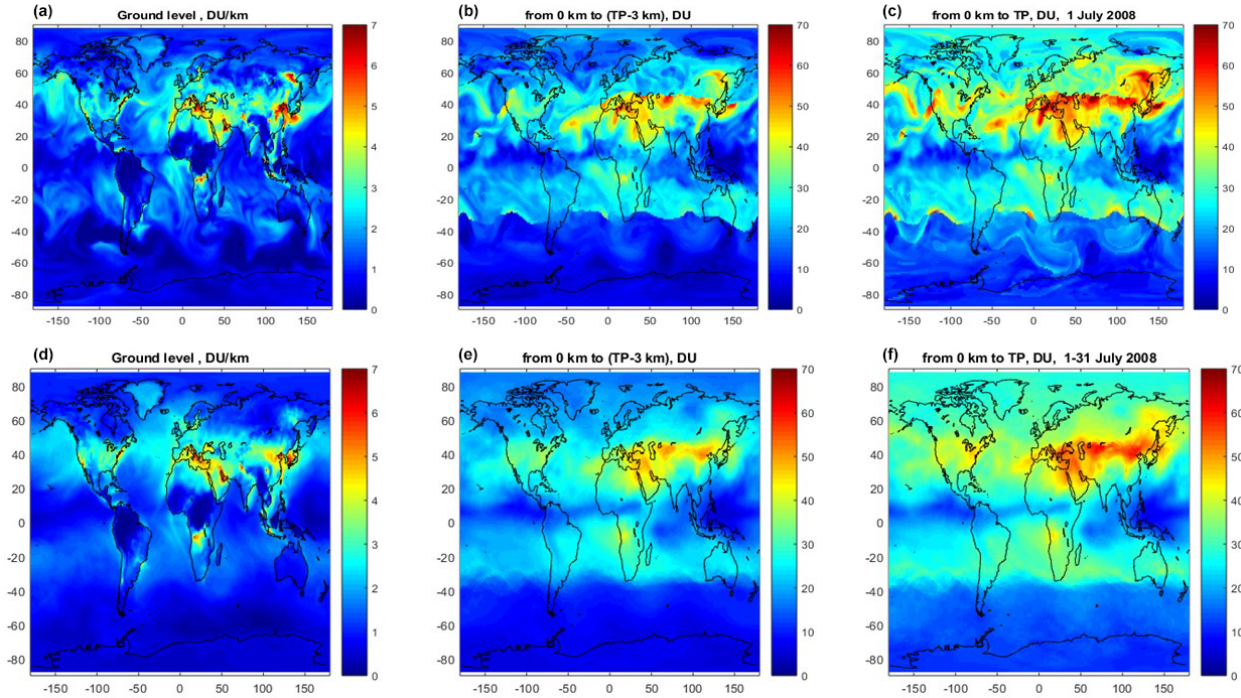
Figure 3. Simulations with SILAM for 1 July 2008 (a, b, c) and monthly mean for July 2008 (d, e, f) . (a, d) Ground-level ozone, (b, e) truncated tropospheric ozone column (from ground to the altitude 3km lower than the tropopause), and (c, f) the full tropospheric ozone column (from ground to the